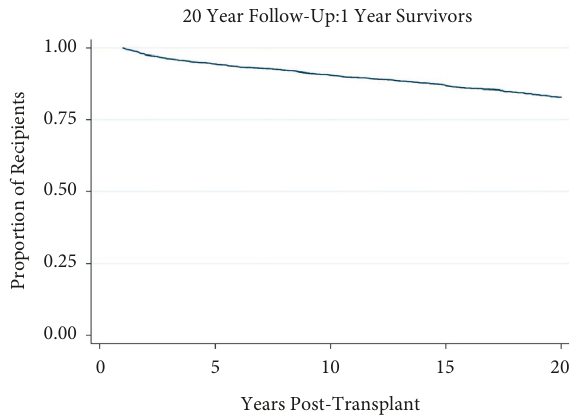
Figure 1: Kaplan–Meier survival function over time for 1-year survivor pediatric liver transplant recipients.